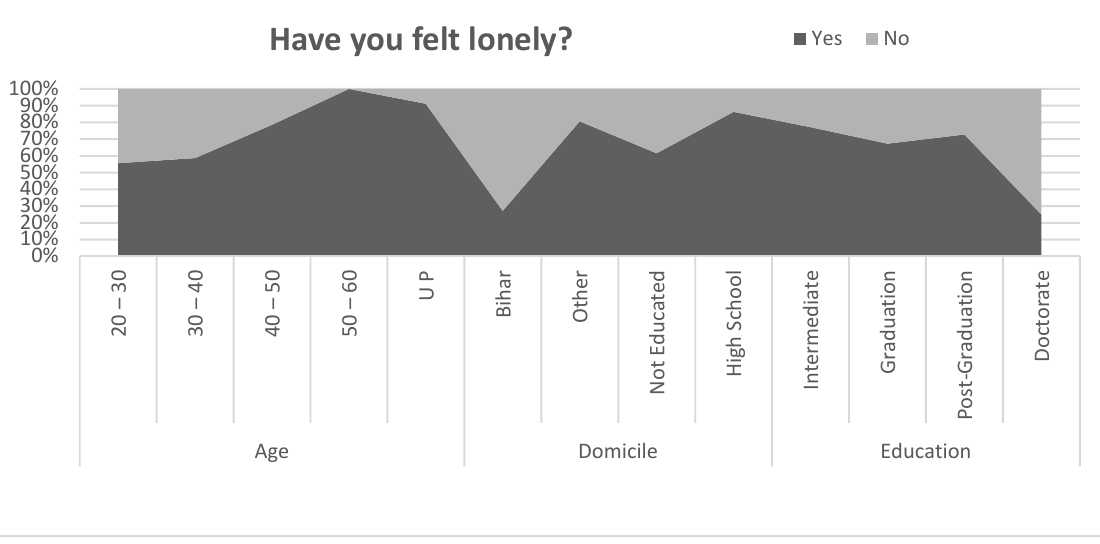
Figure 6. Comparison of feeling hopeful about future.